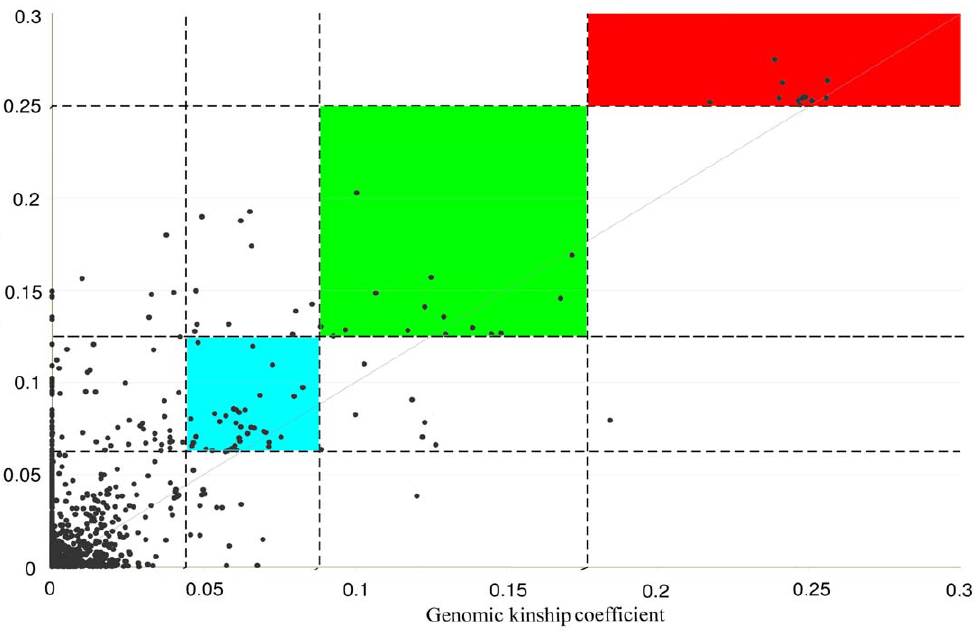
Figure 6. Pairwise kinship coefficients based on the genomic data ( W SNP ) in a substructured population plotted against that based on pedigree data ( W PED ). The vertical dotted lines are lower boundaries of inference criteria for the 3 rd , 2 nd and 1 st degree relationships as in Table S1. The relationships supported by both pedigree and genetic kinship coefficients are shaded red for first degree relatives, green for second degree and turquoise for third degree relatives.